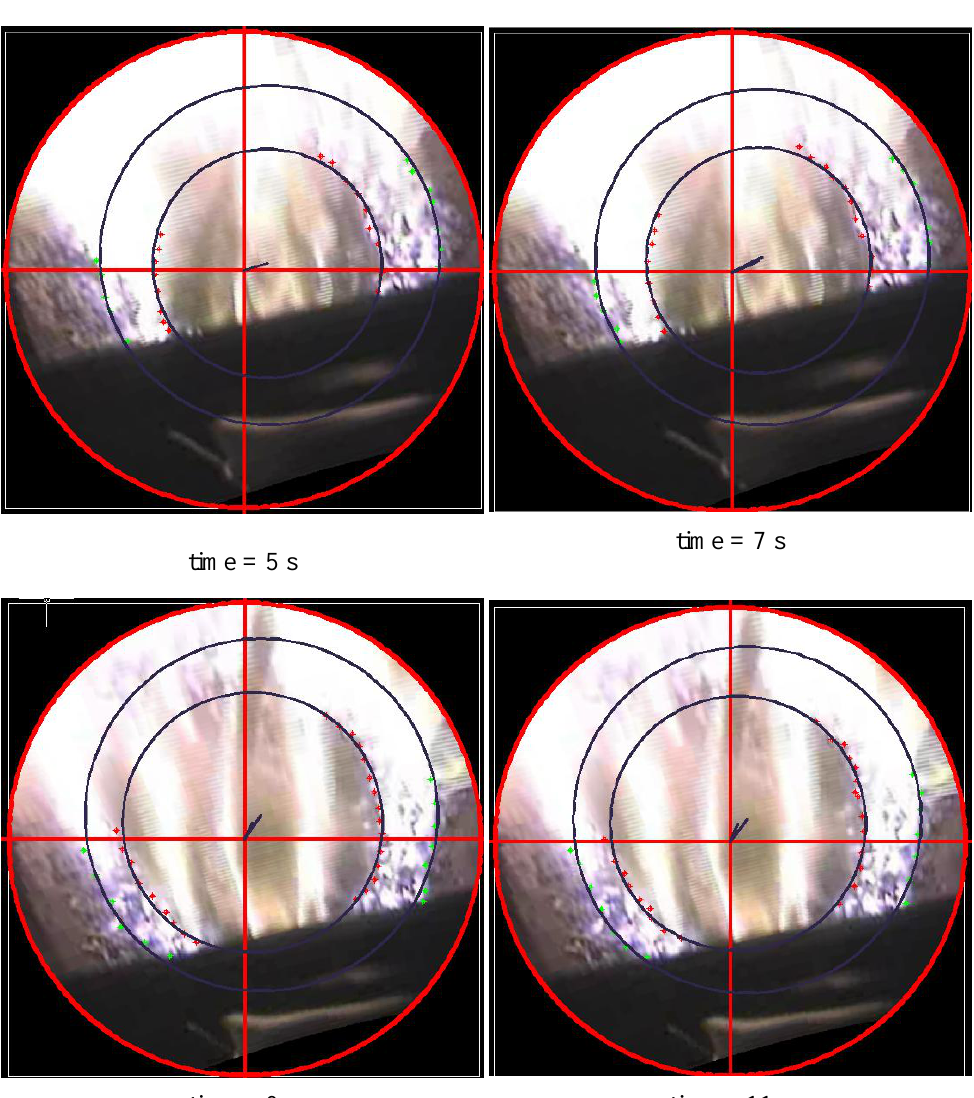
Figure 10. Orthophotos with adjusts at different